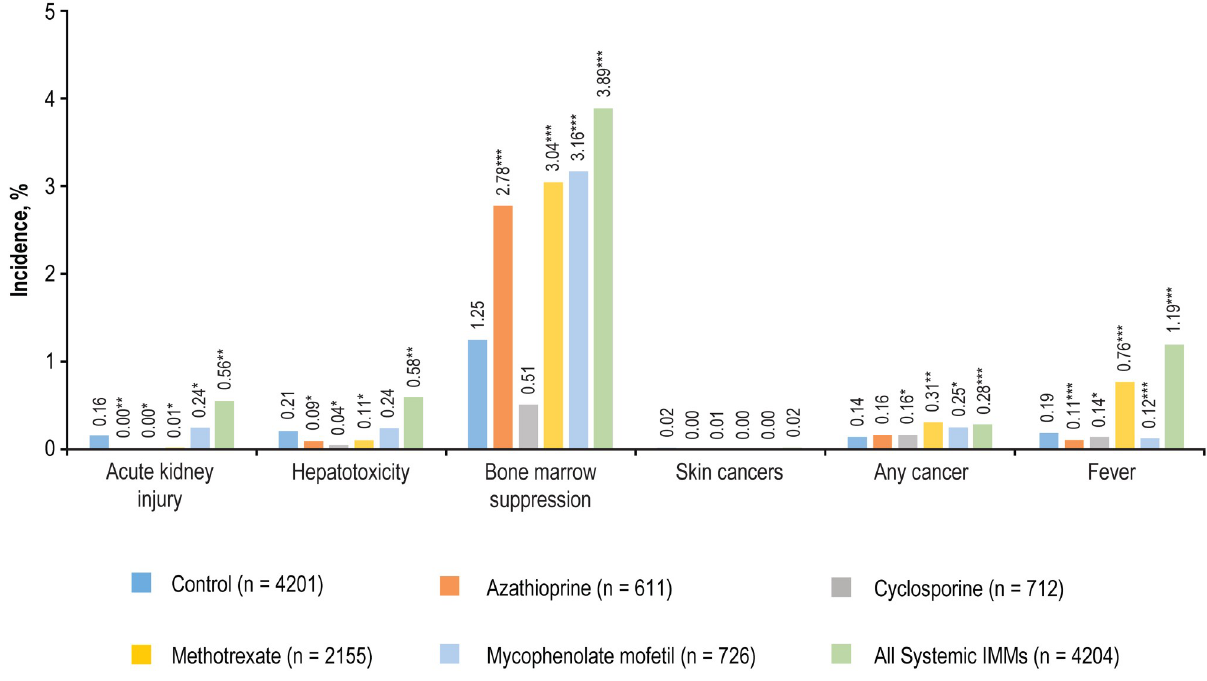
Fig 3. GLM-adjusted incidence of IMM-related clinical events in patients using systemic immunosuppressants vs controls. � P < 0.05; �� P < 0.001; ��� P < 0.0001. Controls shown represent the aggregated controls across all systemic IMMs. P -values of individual IMMs are in comparison with matched controls.